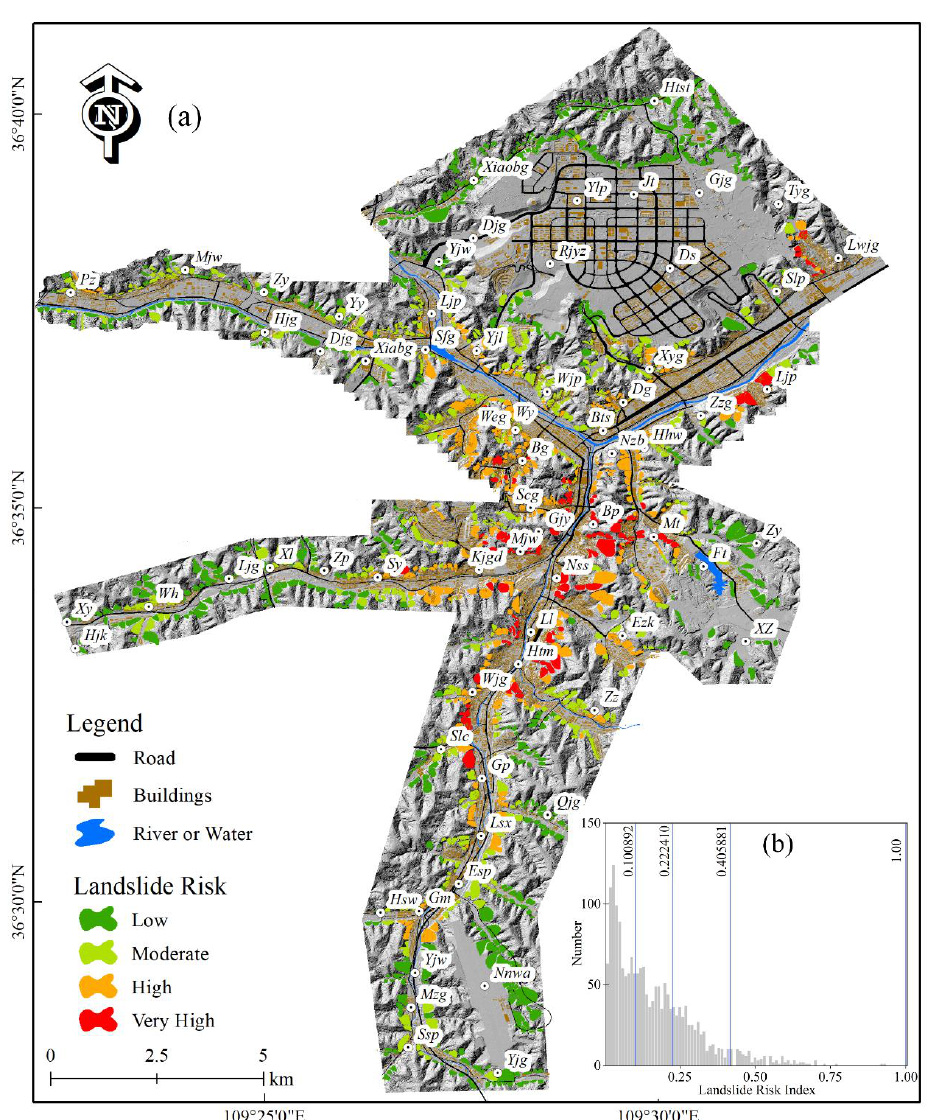
Figure 13. Landslide risk map of the study area in ( a ), and the distribution of the landslide risk index using the natural breaks in ( b ).